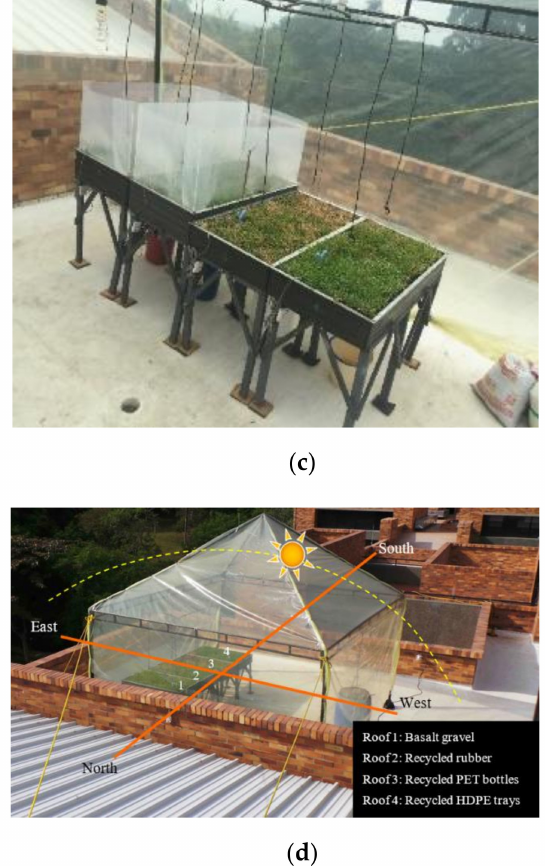
Figure 3. Rain simulator system: ( a ) Overall picture of rain simulator and water supply tank. ( b ) Floating irrigation system. ( c ) Water retainers. ( d ) Spatial orientation of the rain simulation experiment with respect to cardinal points.